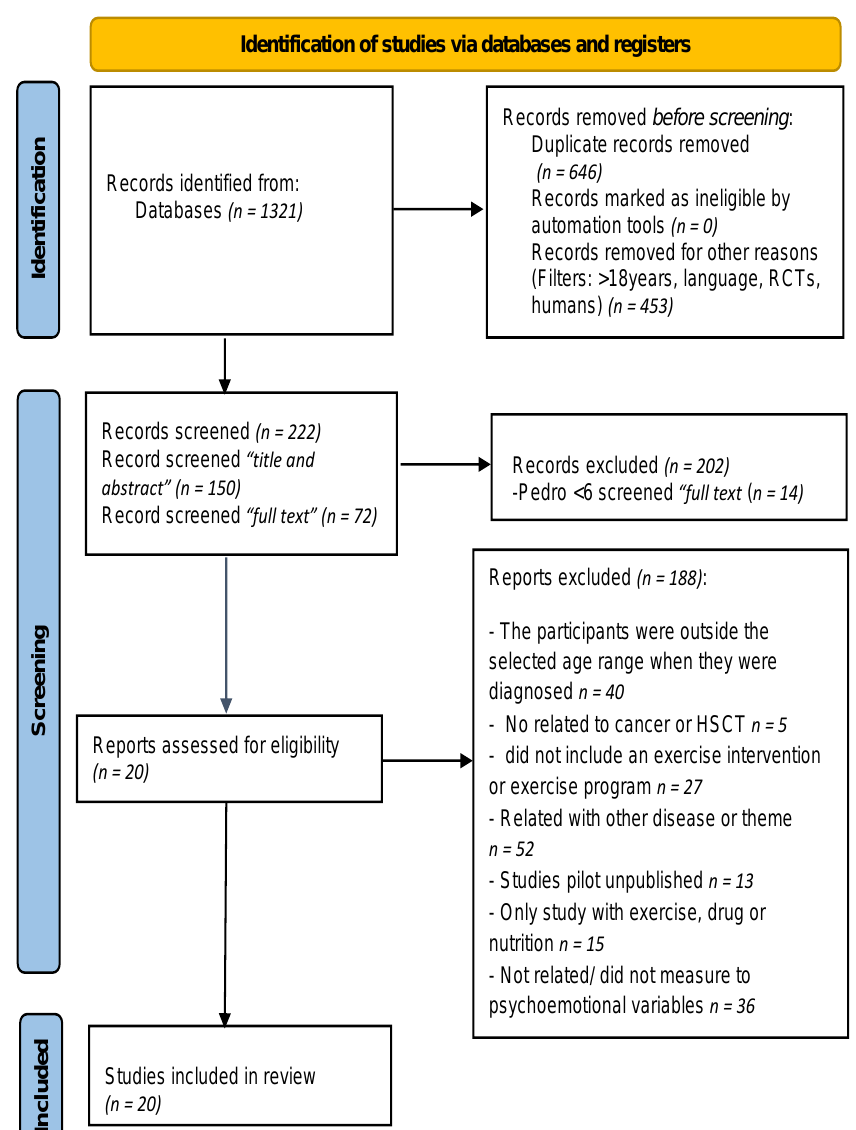
Figure 1. Systematic review flowchart.